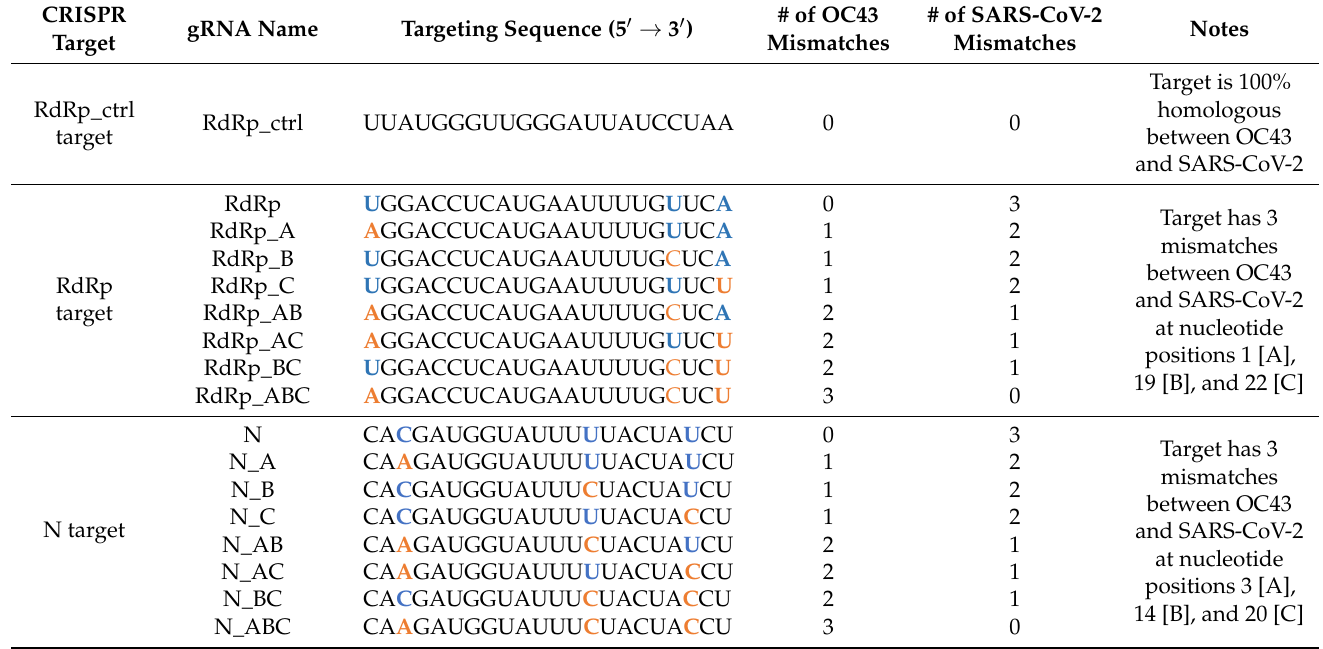
Table 4. gRNA sequences and mismatch location. A, B, and C in gRNA name represent SNPs in the gRNA sequence. Orange nucleotides match SARS-CoV-2 sequence; blue nucleotides match OC43 sequence; black nucleotides are consensus